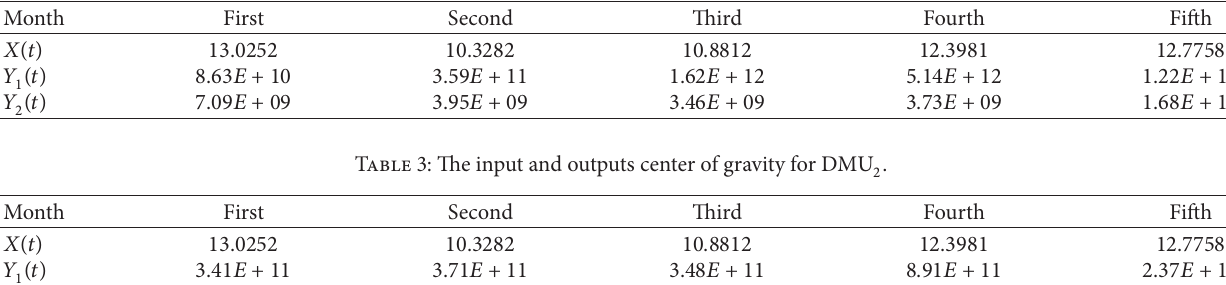
Table 2: The input and outputs center of gravity for DMU 1 .